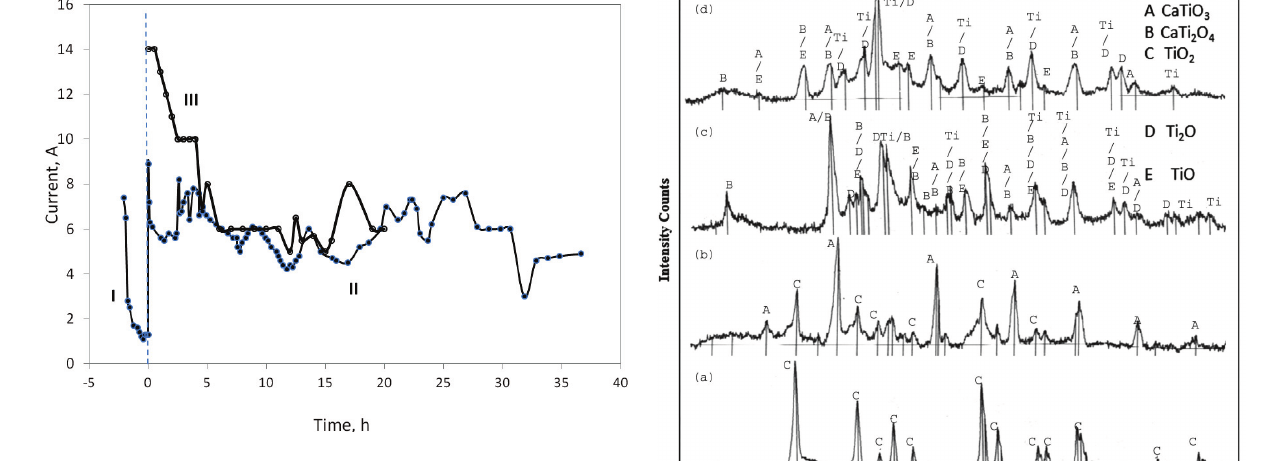
Figure 3. Combined figure of XRD on TiO fore electrolysis, (b) after 5 h electrolysis, (c) after 15 h electrolysis, (d) after 19 h electrolysis.